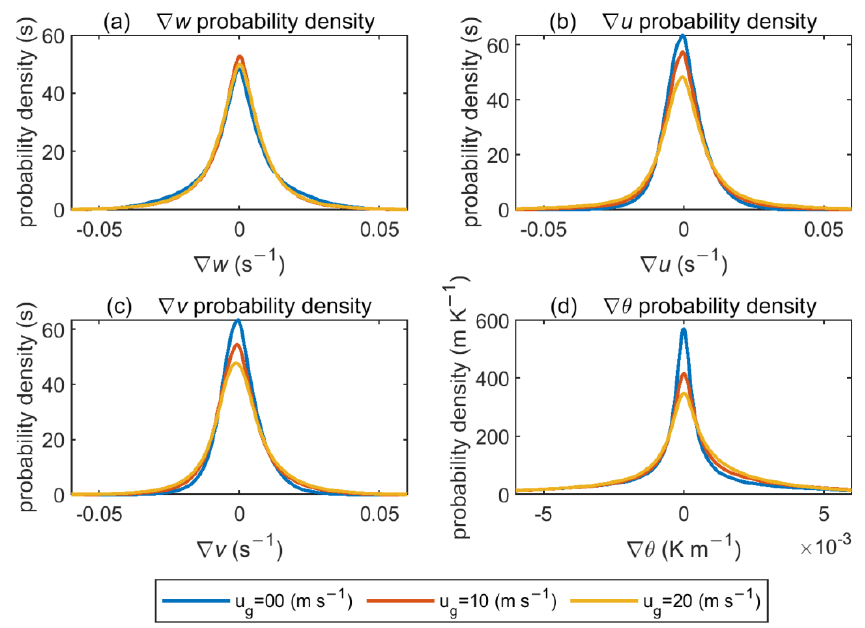
Figure 6. As in Figure 4, but at z / z i = 0.1.